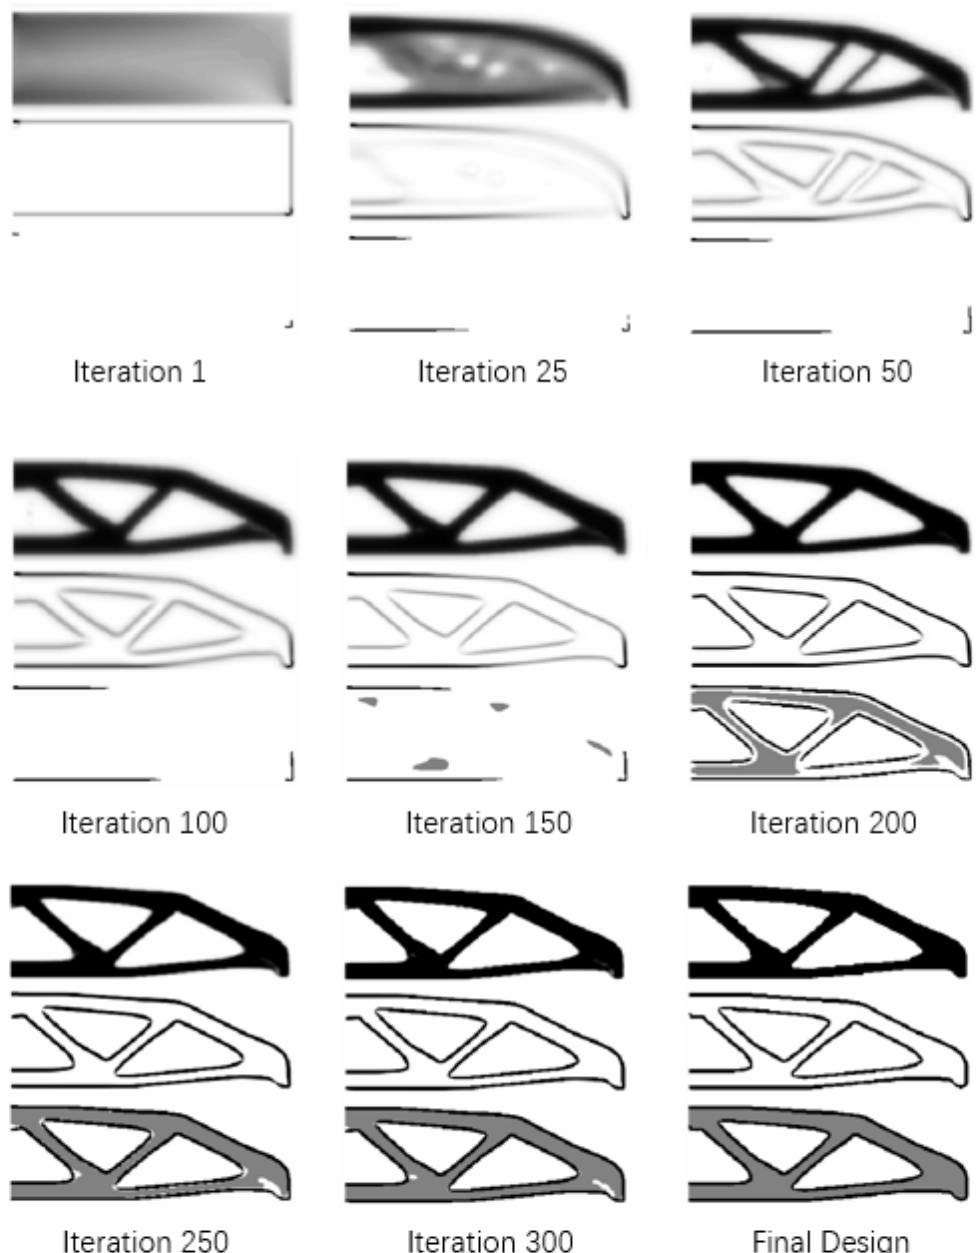
Figure 8. The topology of substrate domain ( 𝜌 (cid:3006) ) and boundary layer ( ‖𝛻𝜑 (cid:3006) (cid:3550)‖ (cid:3080) (cid:3364)(cid:3364)(cid:3364)(cid:3364)(cid:3364)(cid:3364)(cid:3364)(cid:3364)(cid:3364)(cid:3364)(cid:3364) ) evolution.